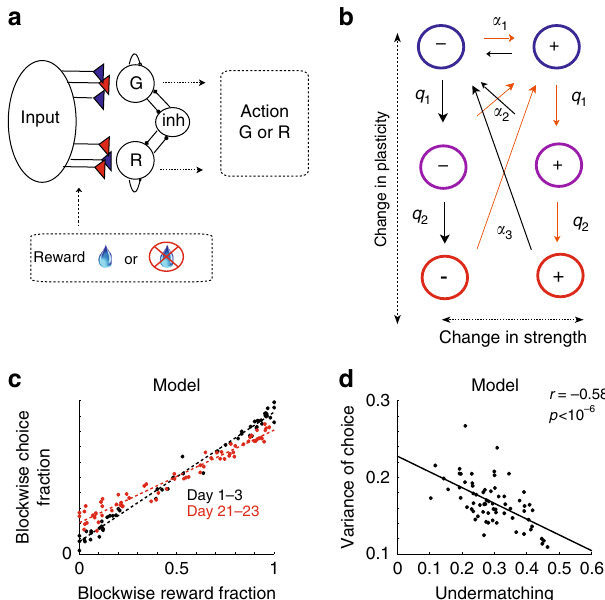
Fig. 10 The metaplastic model of synapses (the cascade model 52 ) can capture key aspects of experimental data. a Network model. A decision is made according to the competition between the two action selection populations (G: choosing Green target; R: choosing Red target), mediated by the inhibitory population. The competition is determined by synaptic strength between the input population and the action selection populations. These synapses are plastic, and they encode the value of Green target and Red target 8,12,20,56,61 . b The cascade model of synapses. Each synapse makes Markov transitions between states with a different strength (depressed − , or potentiated + ) and plasticity (upper states are more plastic) with given probabilities, where transition probabilities are designed to be ordered as α 1 (cid:2) α 2 (cid:2) α 3 ; q 1 (cid:2) q 2 . Note that transition probabilities are logarithmically distributed so that deeper states are harder to enter, and harder to leave. In general, the number of metaplastic states (vertical states) can be more than three 8,52 . Here we show three states for